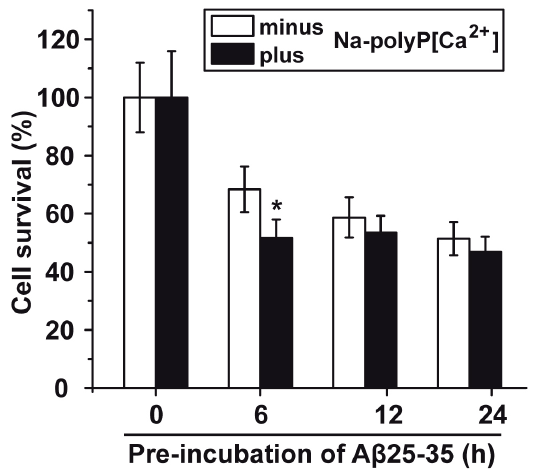
Figure 4. Viability of PC12 cells incubated with the amyloid β -protein fragment A β 25-35 that had been pre-incubated with Na-polyP[Ca 2+ ]. The peptide had been pre-incubated in distilled water for 6 to 24 h, or was immediately used after solubilization. During the pre-incubation period A β 25-35 remained untreated or was treated with 30 µ g/mL of Na-polyP[Ca 2+ ] (minus/plus Na-polyP[Ca 2+ ]), as described under “Materials and Methods”. After that, the respective peptide sample was added to the cell culture (8 × 10 4 PC12 cells/mL) at a concentration of 5 µ M and incubated for 12 h. Then the viability of the cells was determined by the MTT assay; the cell survival rate was calculated and is given as % to the corresponding control culture. Data ( ± SD) have been based on ten independent experiments; (*) the significance has been calculated ( p < 0.05).